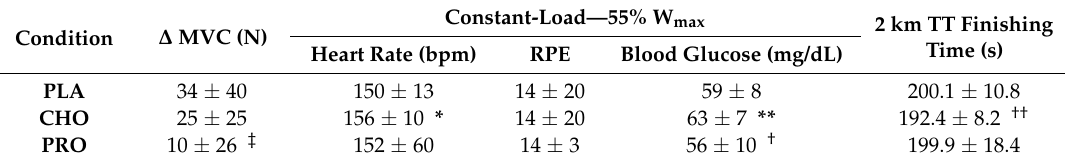
Table 2. The 2 km performance, peak strength, and heart rate, rating of perceived exertion, and